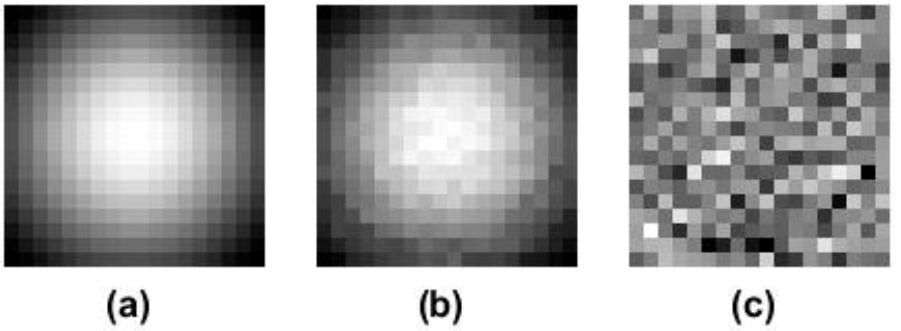
Figure 7. Results of the point spread function in Figure 3 (SNR = 40dB, Sampling Ratio = 0.8). ( a ) the point spread function; ( b ) the estimated point spread function; ( c ) the difference between point spread function and the estimated point spread function.